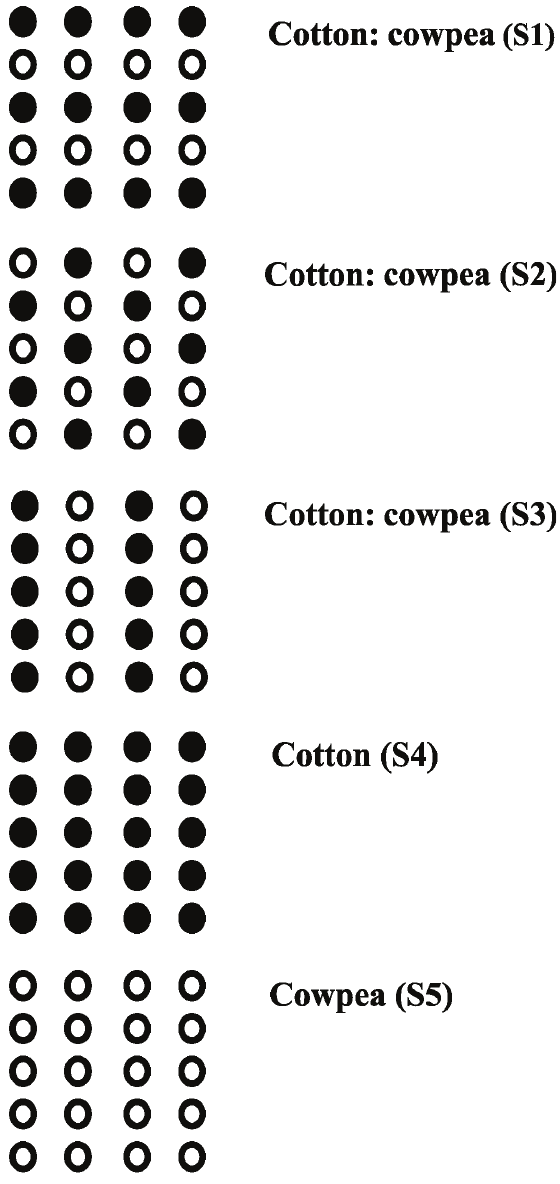
Figure 1 - Layout of experimental units in the cotton–cowpea intercropping systems and monoculture. Cotton with colored fibers (closed circles) and cowpea (open